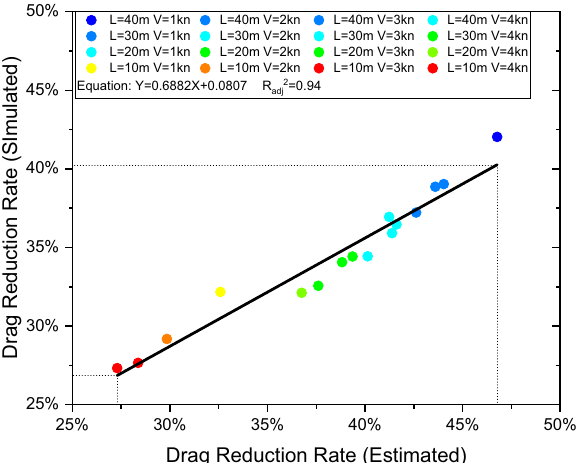
Figure 16. The linear fitting equation for the drag reduction rate between the simulated one and the estimated one using the average velocity.